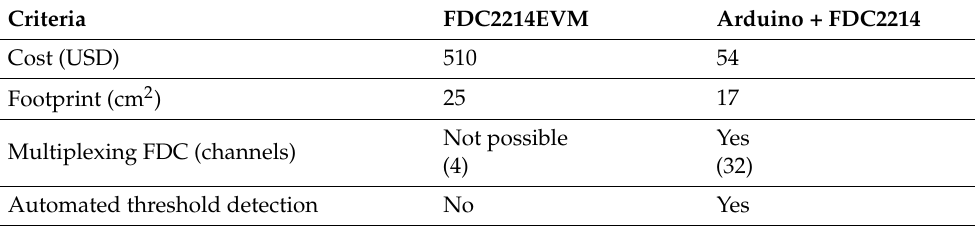
Table 3. Comparison of FDC2214EVM and in-house designed FDC2214 with Arduino.